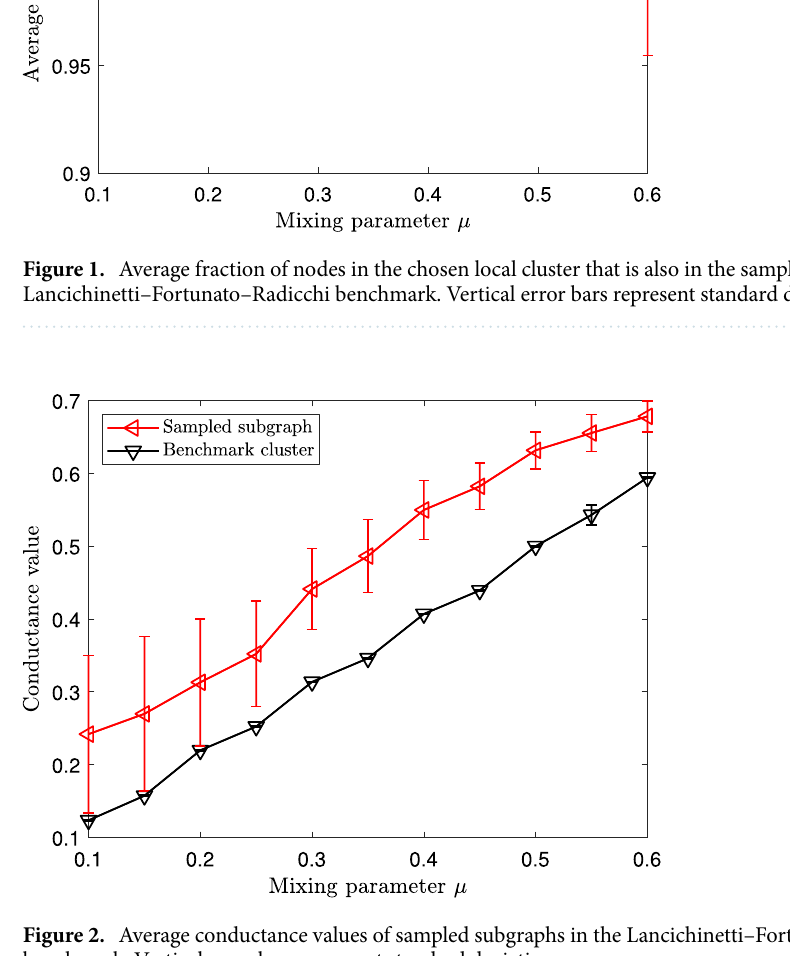
Figure 2. Average conductance values of sampled subgraphs in the Lancichinetti–Fortunato–Radicchi benchmark. Vertical error bars represent standard